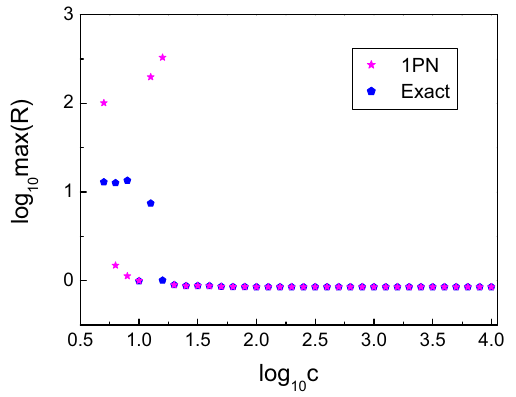
(cid:13) x 2 + y 2 on c